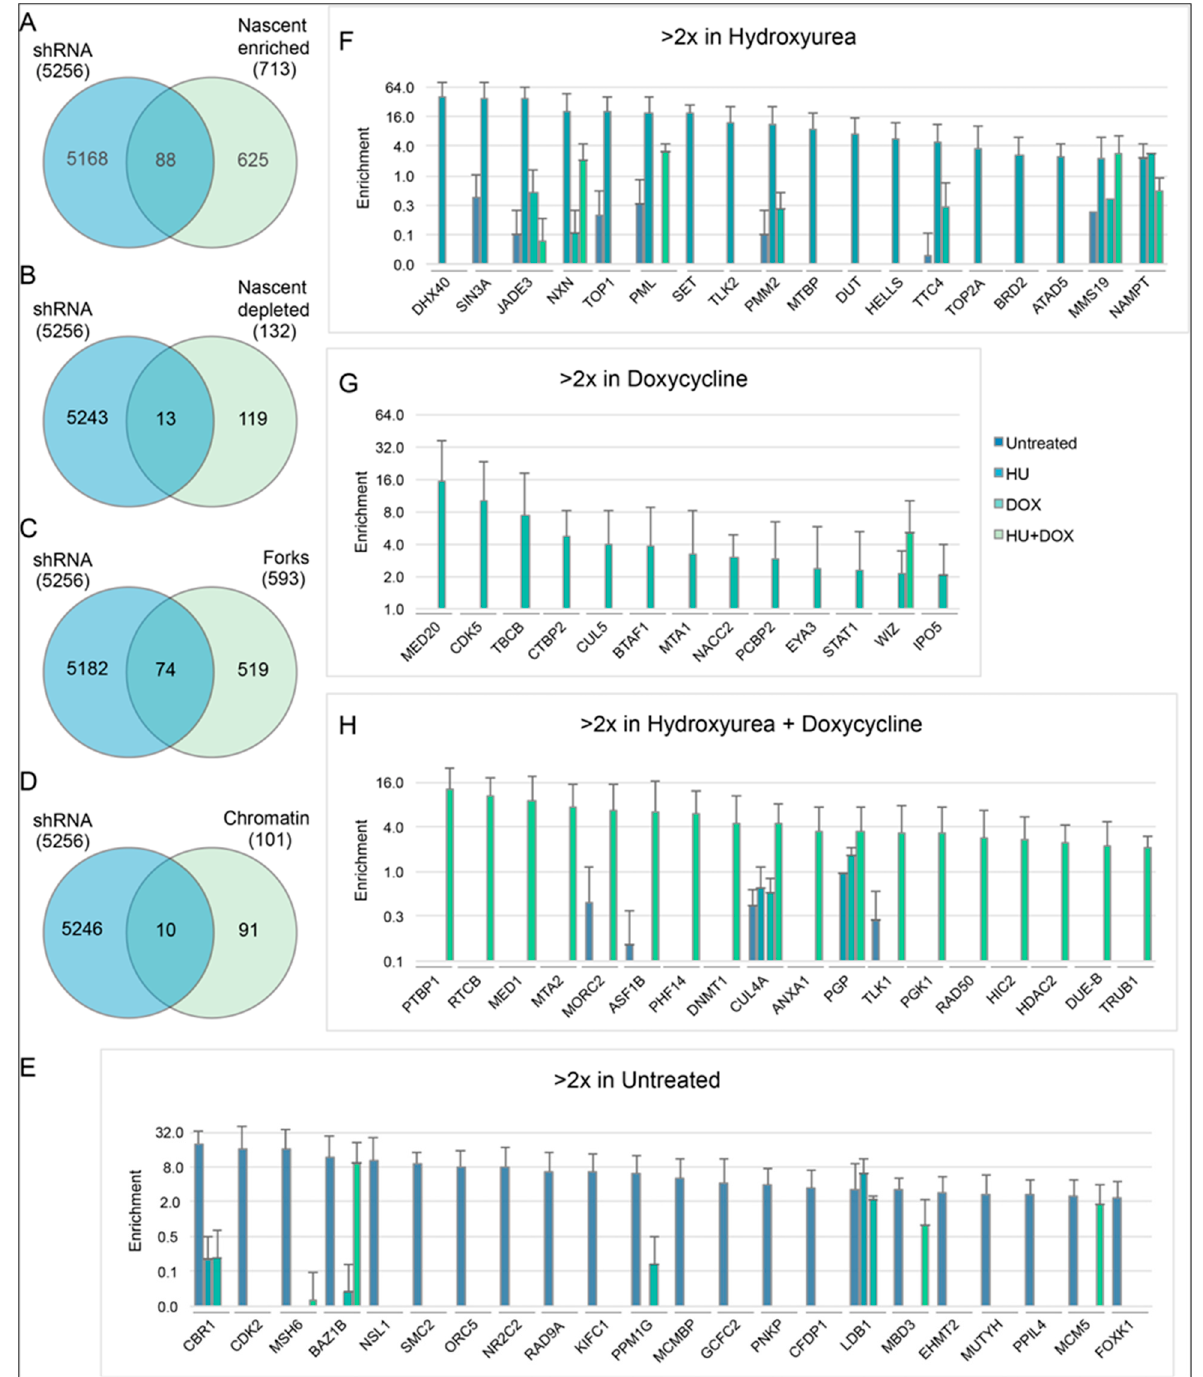
Figure 6. Loci corresponding to proteins present on nascent or mature DNA. ( A – D ) Venn diagrams for all shRNAs from all treatments in the screen compared with loci for proteins enriched or depleted at nascent DNA sites, enriched at replication forks, or enriched at mature chromatin. ( E – H ) Enrichment values of shRNAs with >2-fold enrichment in different treatments that correspond to proteins reported to be significantly enriched at the sites of nascent DNA. (( A – H ), see also Supplementary Table S6). Most shRNAs were enriched only in one treatment. The legend for the graphs is to the right of panel ( G ).